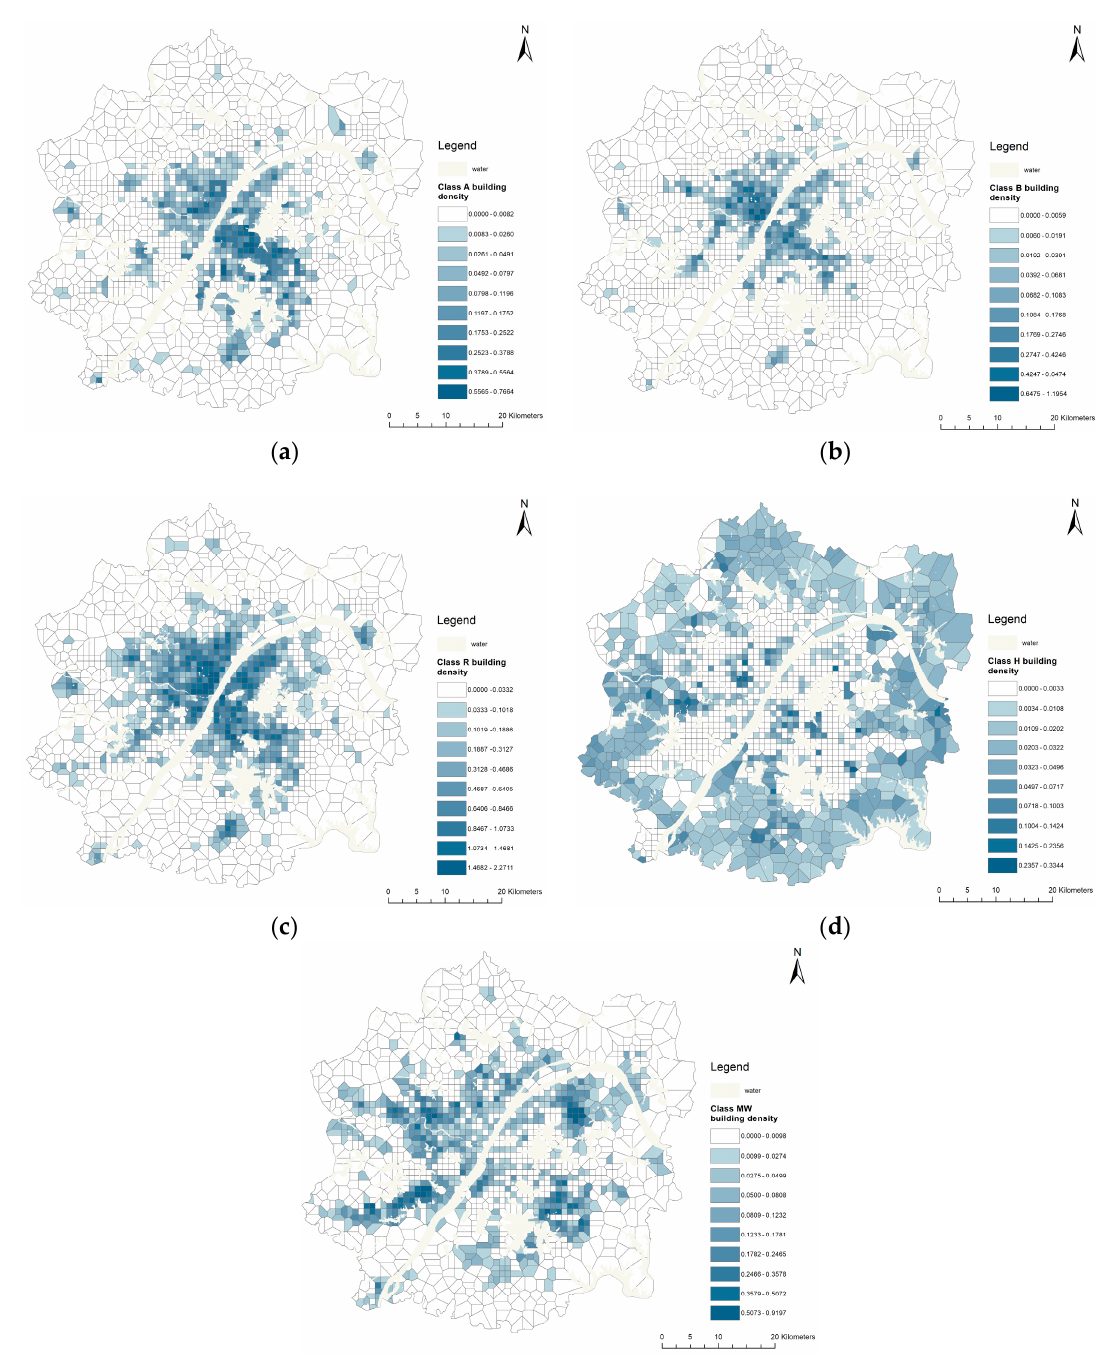
Figure 6. Building density statistics based on Grid Voronoi: ( a ) Class A (administrative and public service) building density; ( b ) Class B (commercial service facility) building density; ( c ) Class R (residential) building density; ( d ) Class H (development and construction) building density; ( e ) Class MW (industrial and logistics storage) building density.